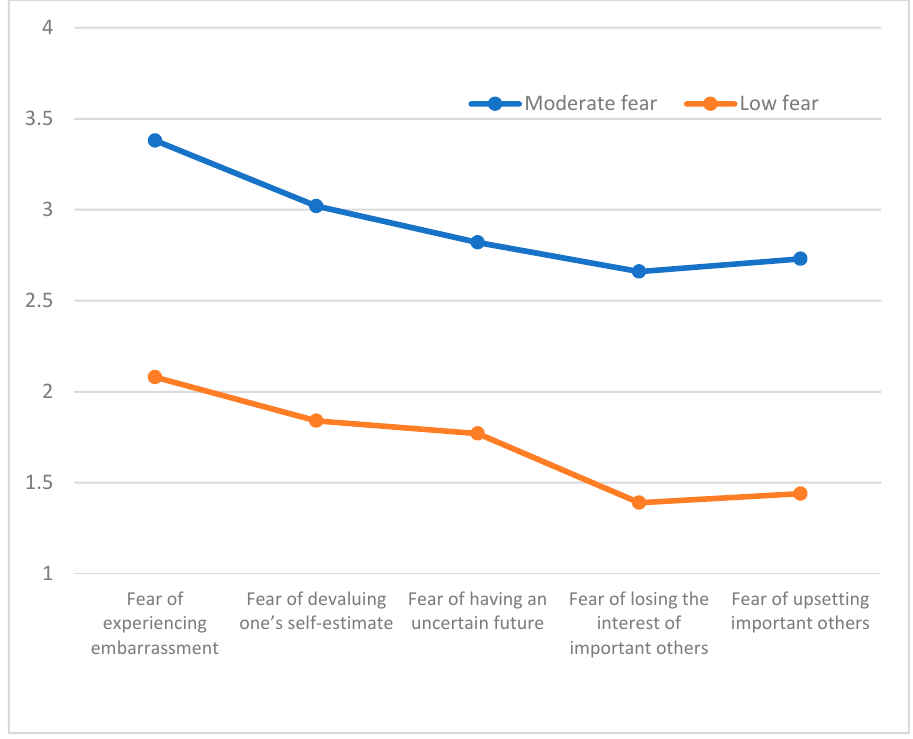
Figure 1. Profiles of Fear of Failure in Sample 1.